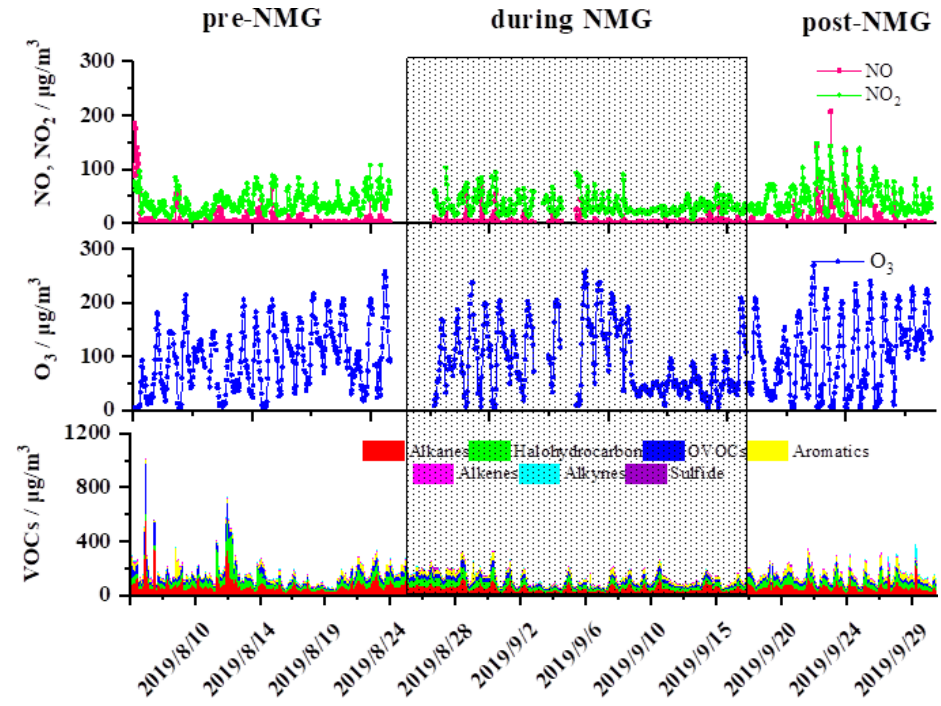
Figure 1. Time series of VOCs and trace gases during the sampling period in Zhengzhou.